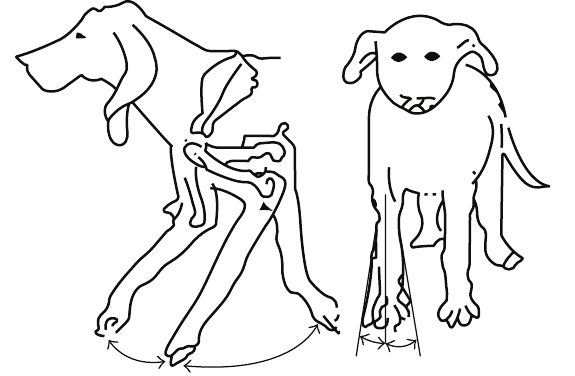
Figure 1: Movements of dog’s shoulder.